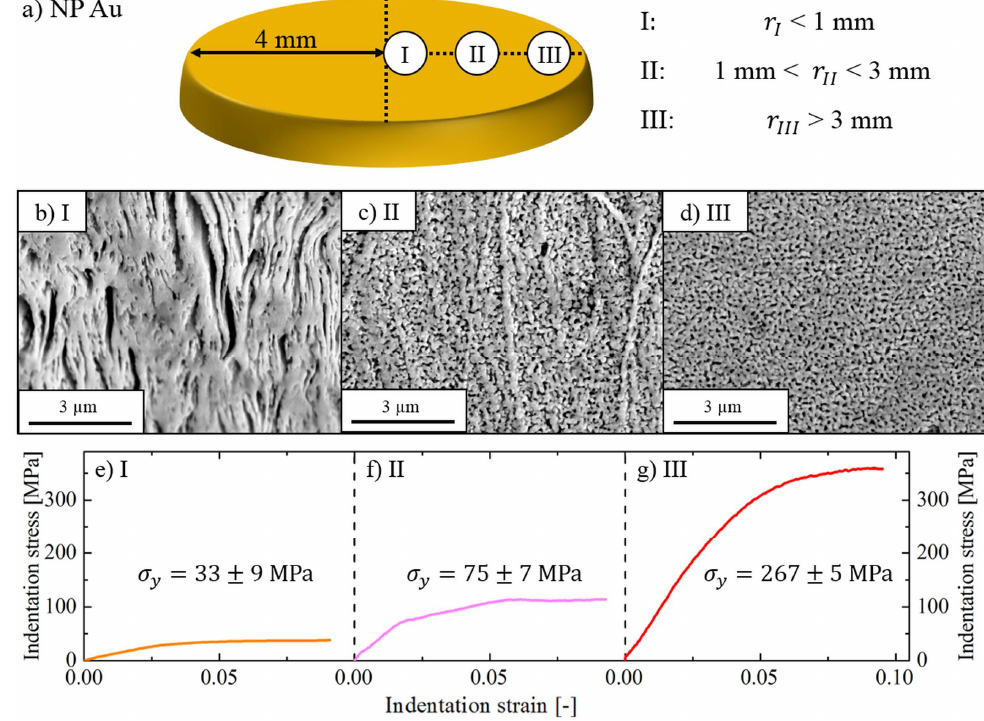
Figure 2. ( a ) Schematic overview of the HPT disk with investigated areas; ( b – d ) SEM images of microstructural features of NP Au in dependence of the disk radius; ( e – g ) Corresponding spherical indentation stress-strain curves of the selected regions.